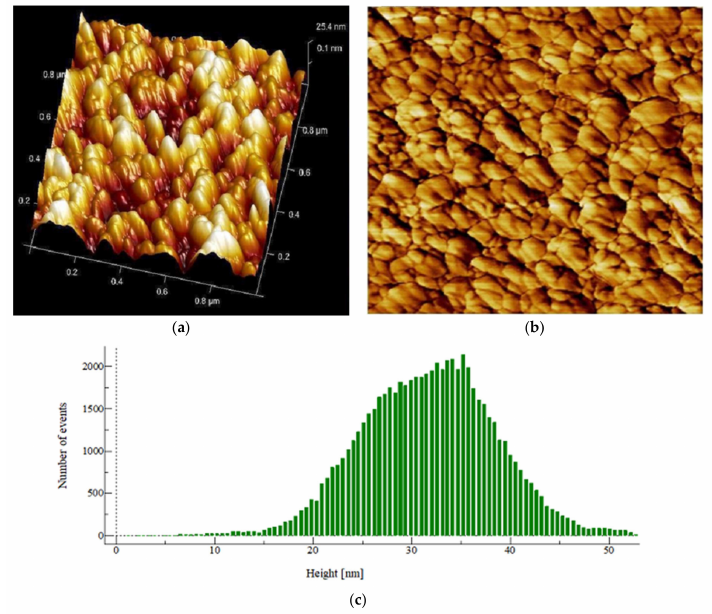
Figure 6. AFM image of S. aureus biofilm surface (untreated) formed on the polycarbonate membrane filter taken at the 1 × 1 µ m scan area in the tapping mode. ( a ) Height topography 3D, ( b ) The structure and complete surface coverage of the biofilm, and ( c ) Height distribution